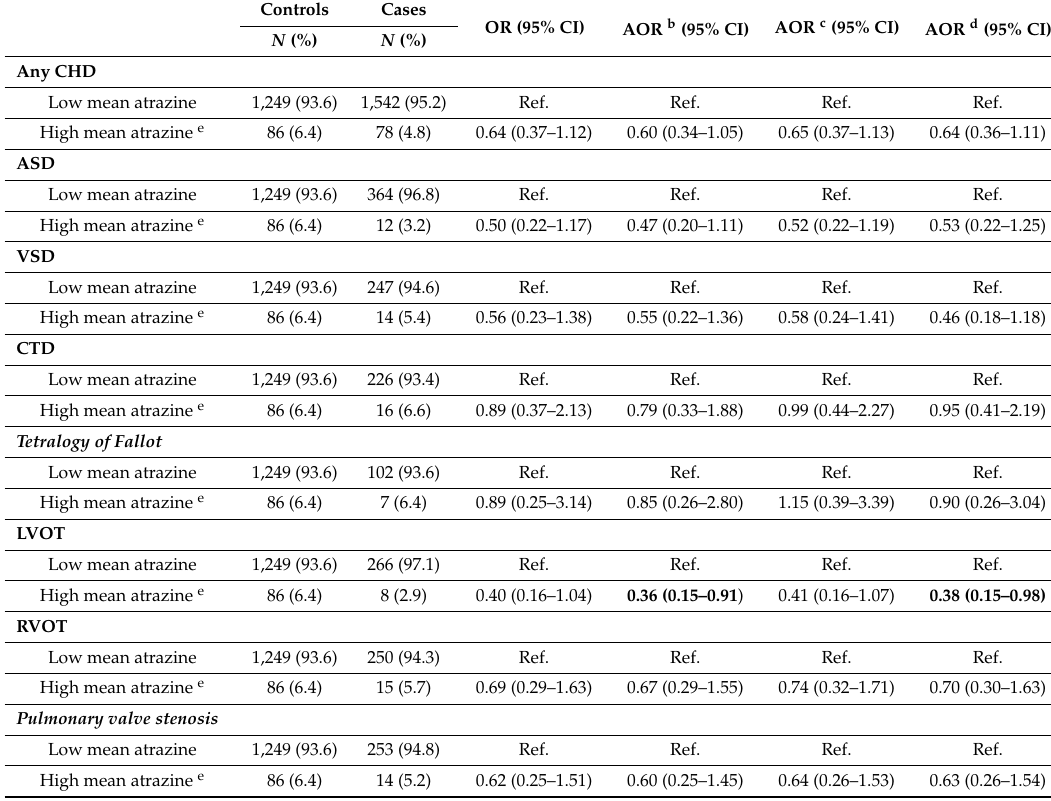
Table 5. Association between estimated high mean atrazine in drinking water and heart